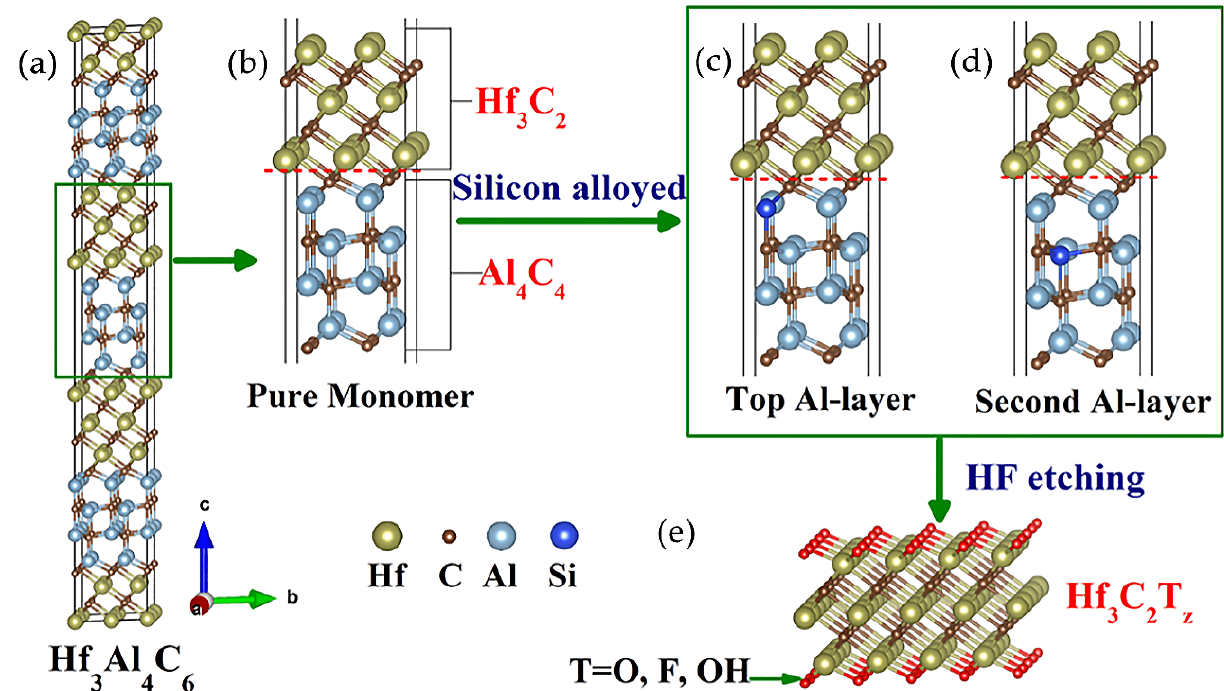
Figure 7. Schematic representation of the synthesis of the Hf 3 C 2 T x MXene: ( a ) Hf 3 Al 4 C 6 supercell without Si; ( b ) monomer Hf 3 Al 4 C 6 . The red dashed line shows the Al 4 C 4 selective etch interface; ( c , d ) possible variants of the arrangement of Si atoms upon doping of the Al 4 C 4 sublayer; ( e ) side view of synthesized MXene Hf 3 C 2 T x . Reprinted with permission from [51] 2017 American Chemical Society.